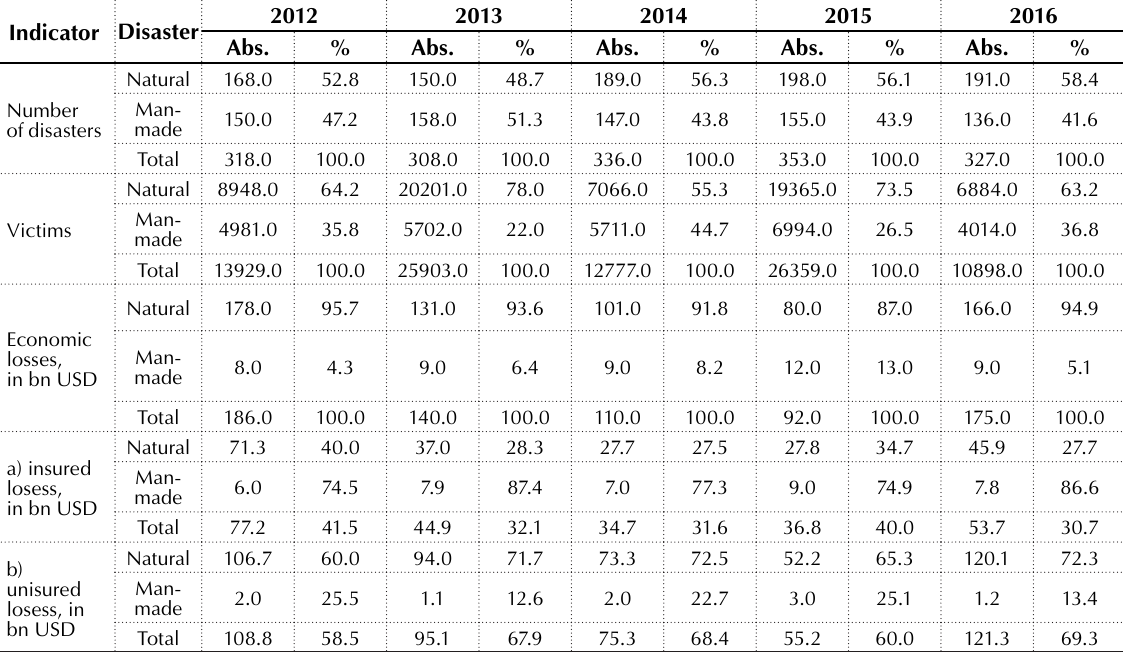
Table 1. The dynamics of vic�ms and economic losses from natural and man-made disasters occurred in the world from 2012 to 2016